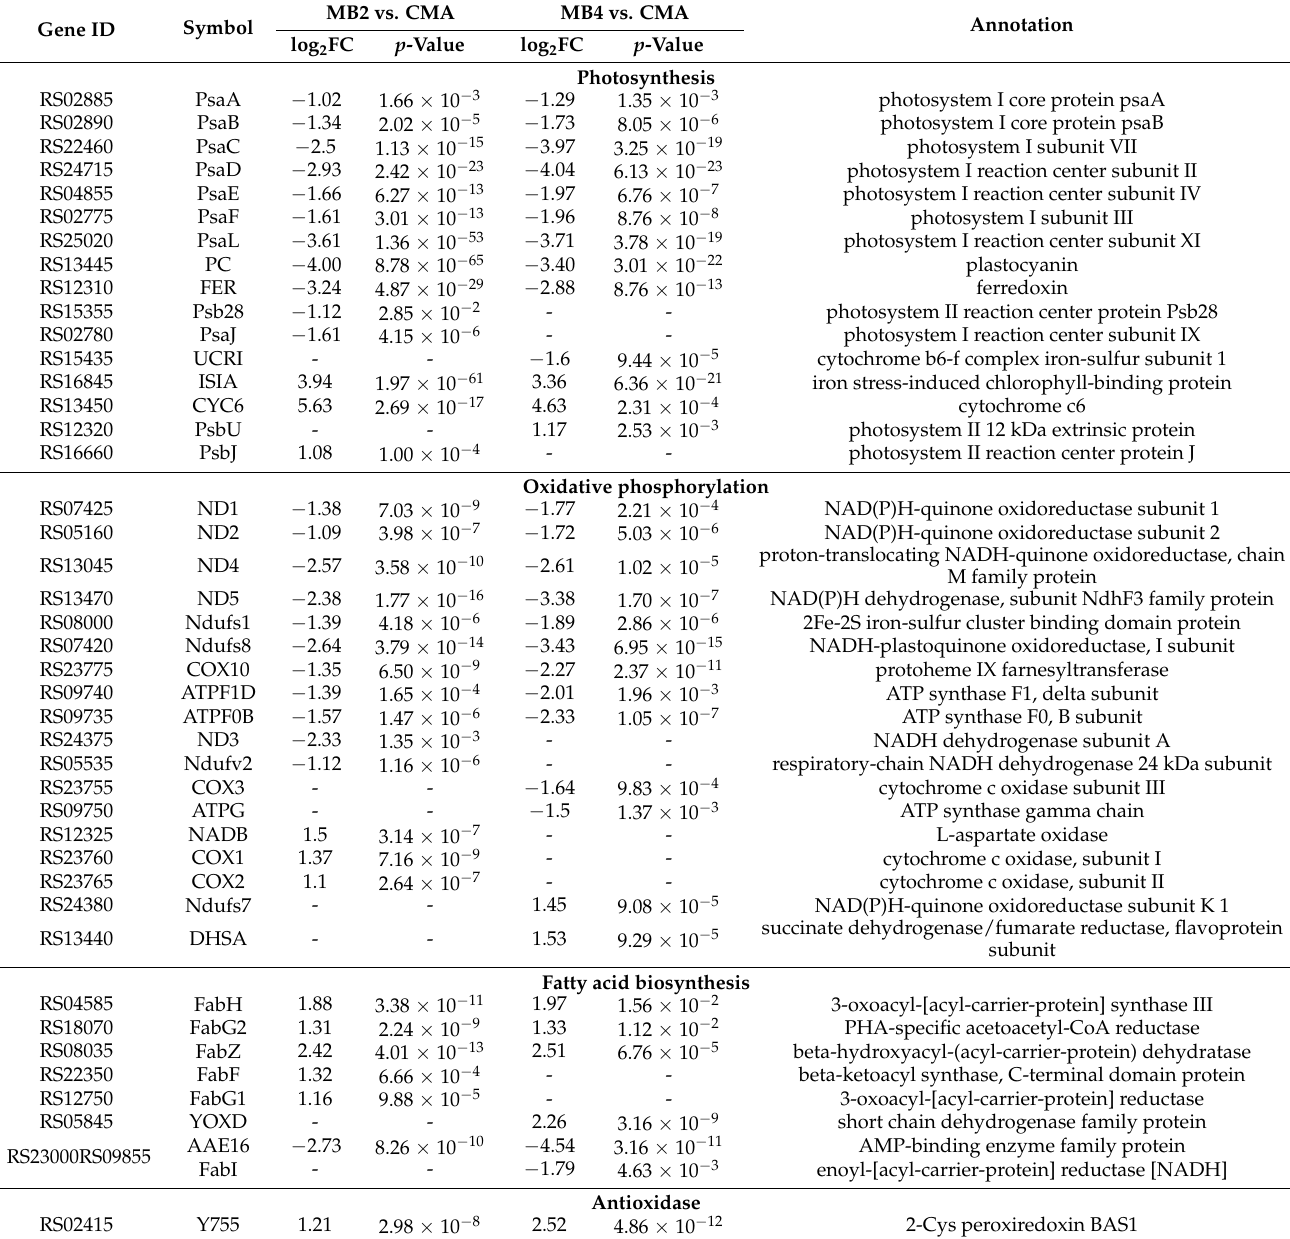
Table 3. Potential candidate genes related to the response to B. laterosporus Bl-zj treatment (FC = fold change). Gene